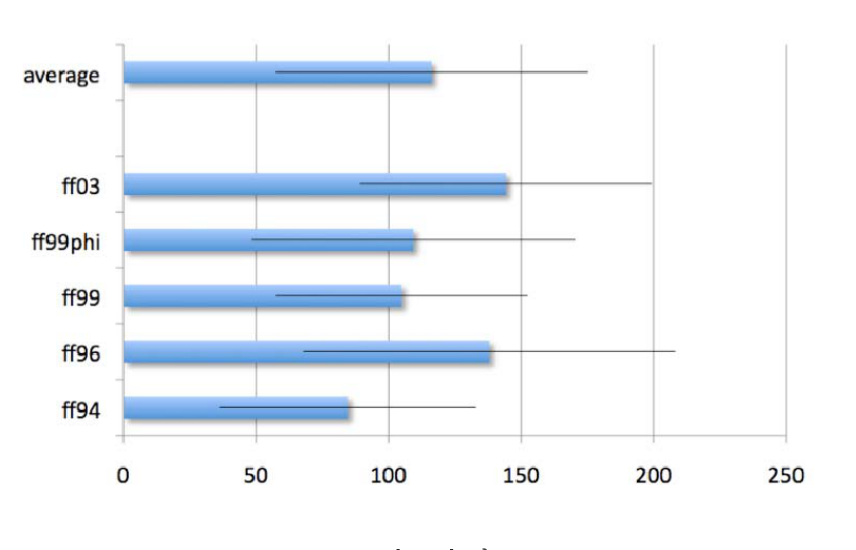
Figure 7. Average simulated relaxation times for D P D P-II, for each forcefield, as characterized by average C=O solvent-accessible surface area. Error estimates are computed from the standard deviation across the 10 starting